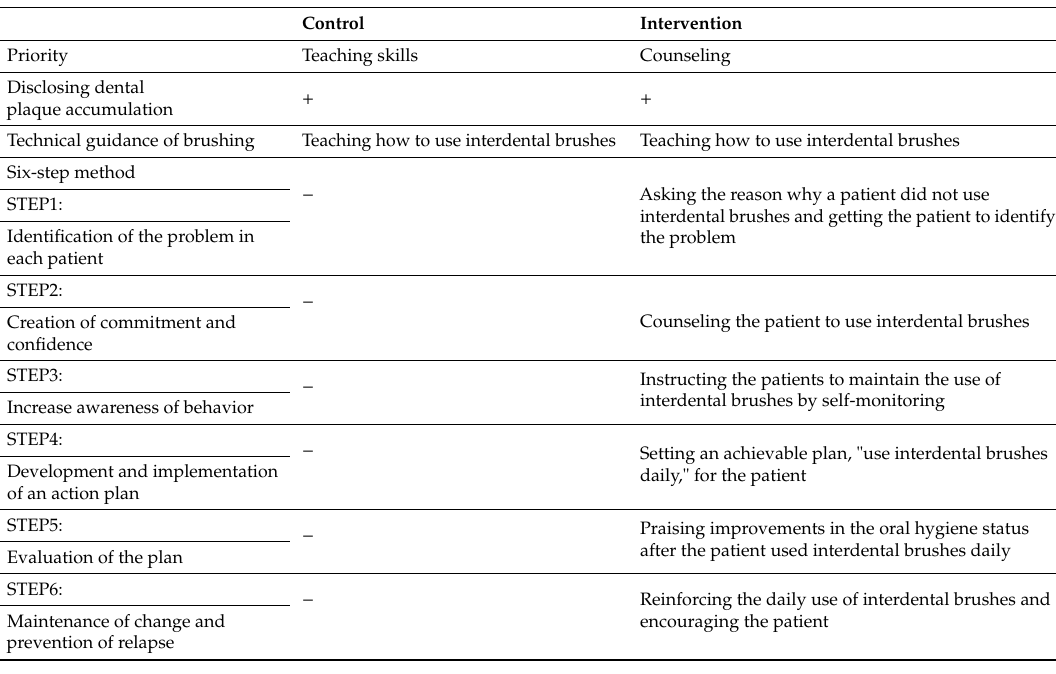
Table 1. Typical oral hygiene instruction in the control and intervention groups. Control Intervention Teaching skills Counseling Disclosing dental plaque accumulation Technical guidance of